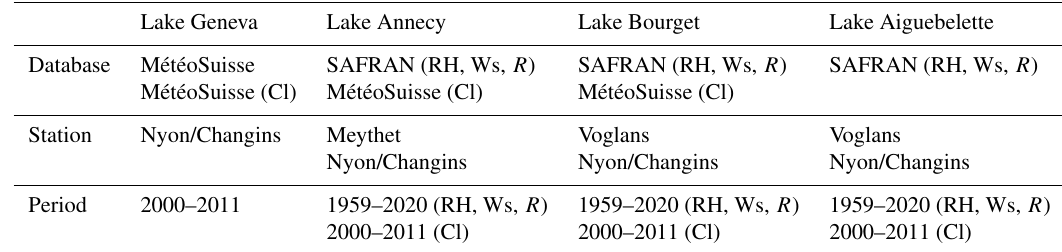
Table 3. Meteorological data sources used for the meteorological patterns calculated from daily means of cloud cover (Cl), relative humid- ity (RH), wind speed (Ws), and rain ( R ) variables, for the four study sites. Lake